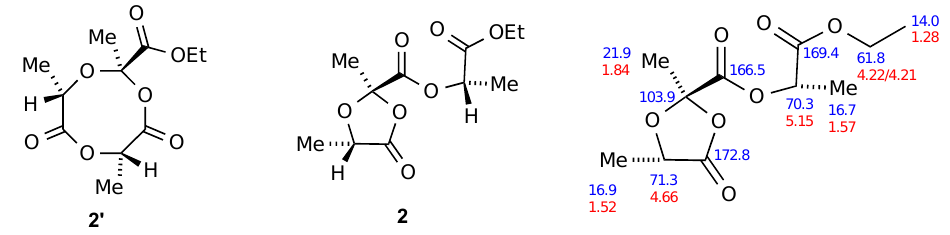
Figure 2. Structures considered for the 2:1 adduct and NMR data.